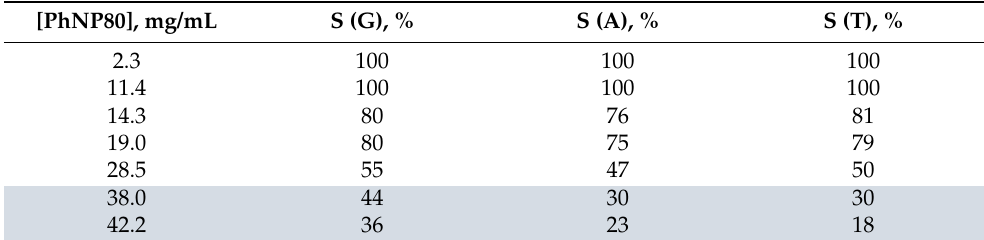
Table 2. The influence of PhNP80 on DPV oxidation signals of guanine (G), adenine (A) and thymine (T). S%—electrochemical coefficient of toxic effect.